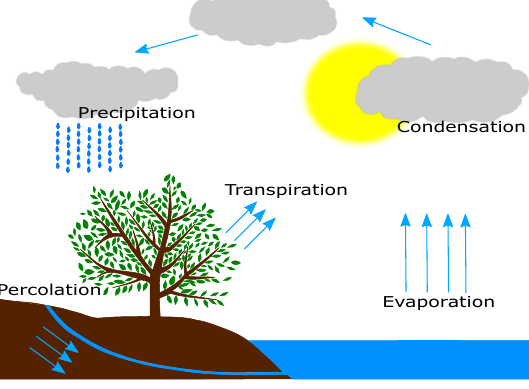
Figure 1. Hydrological water